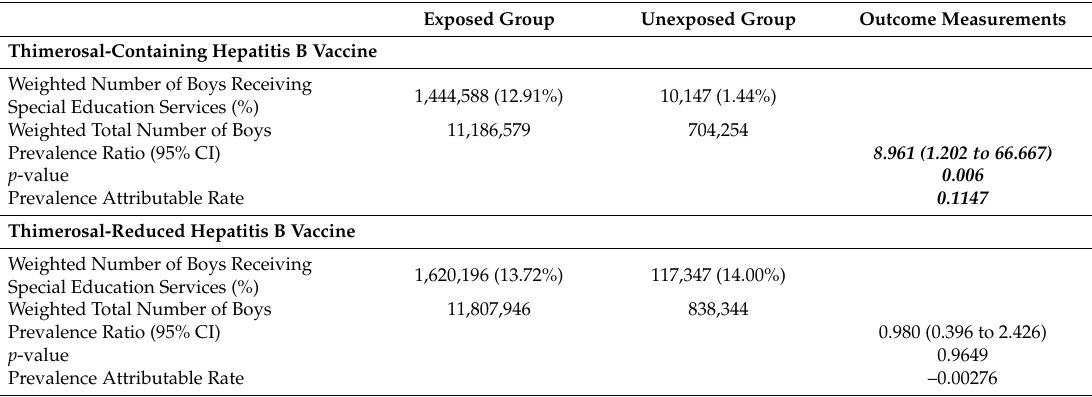
Table 3. A summary of the prevalence ratio for the risk of receiving special education services following infant hepatitis B vaccine exposure using survey frequency modeling 1